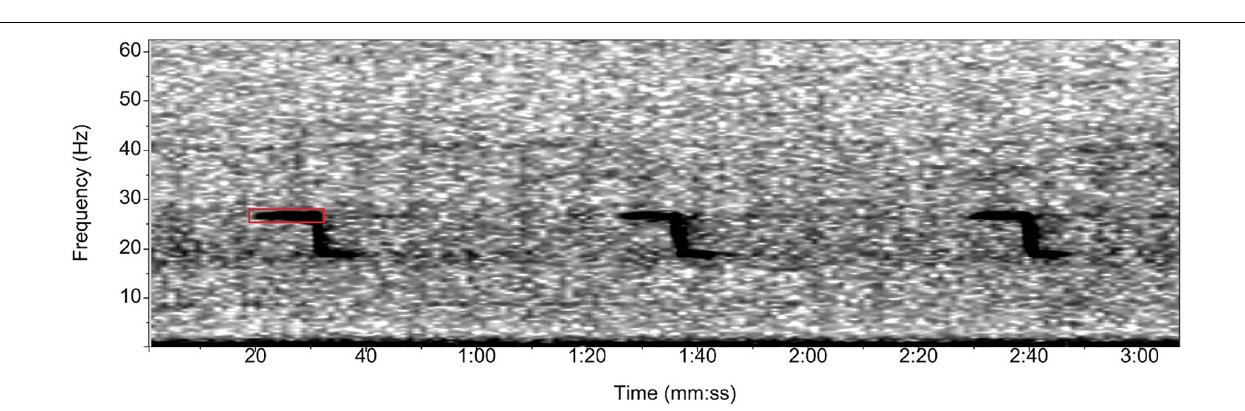
yearly decrease in the frequency of this part of the call (e.g., 0.35 ± 0.3 Hz/year, Gavrilov et al., 2011). The SEIO detector was used only for the Cape Leeuwin dataset, as SEIO pygmy blue whales do not typically occur at the Juan Fernández